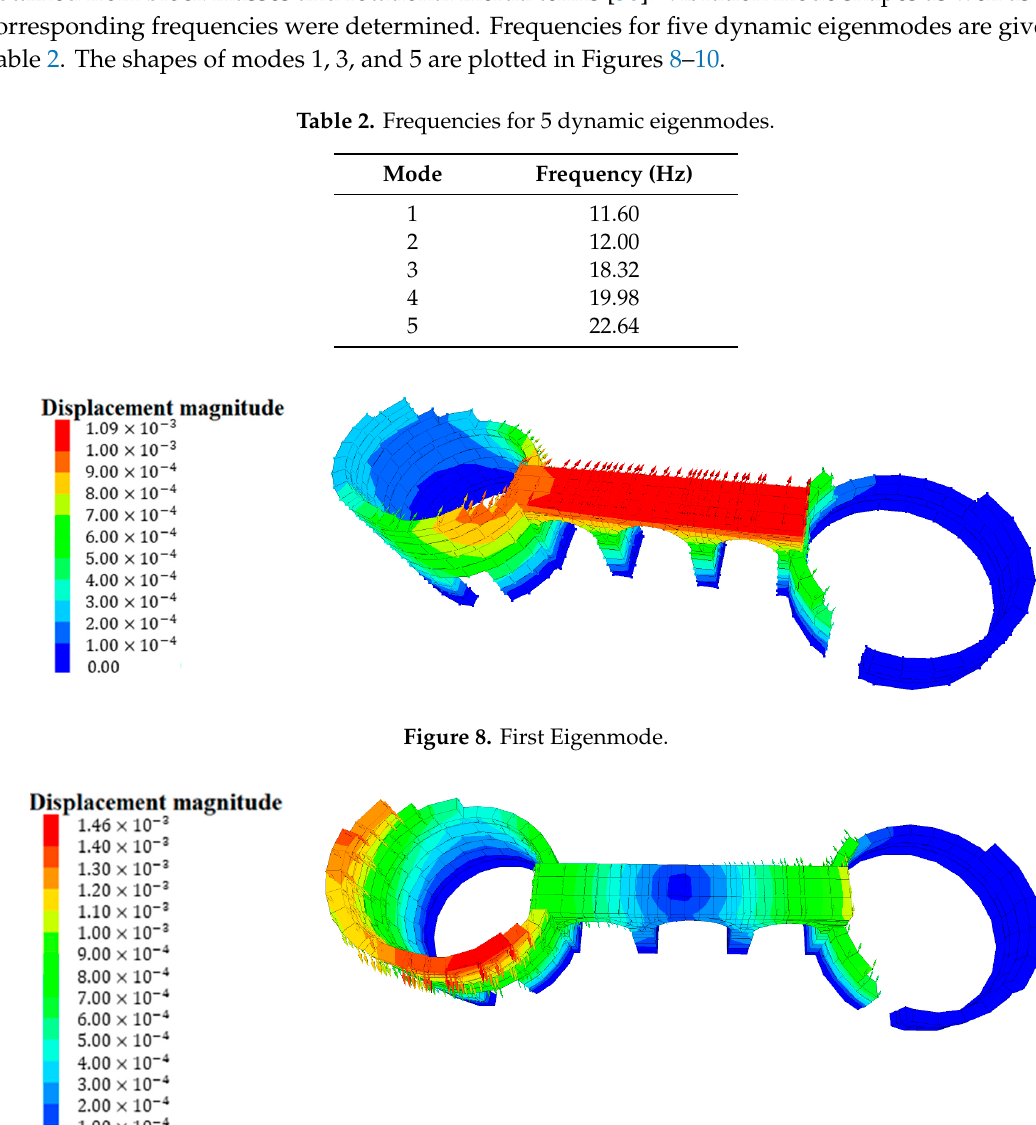
Table 2. Frequencies for 5 dynamic eigenmodes.